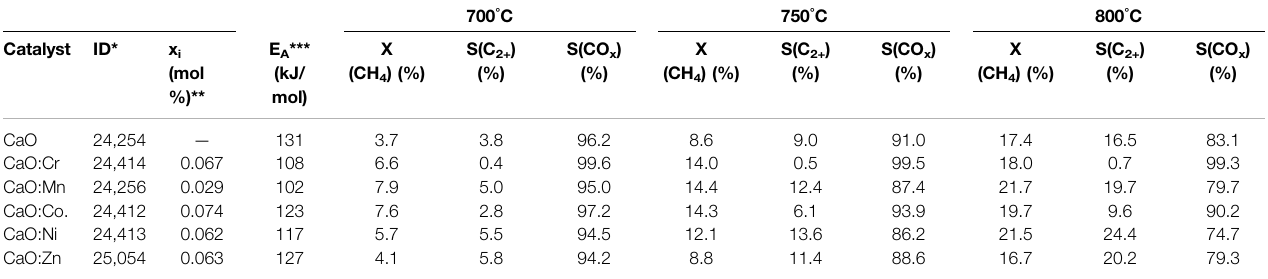
TABLE 1 | Results of OCM tests using transition metal-doped CaO catalysts (50 mg cat, 750 mg SiC, 50 ml/min, CH 4 :N 2 :O 2 = 3:3:1).